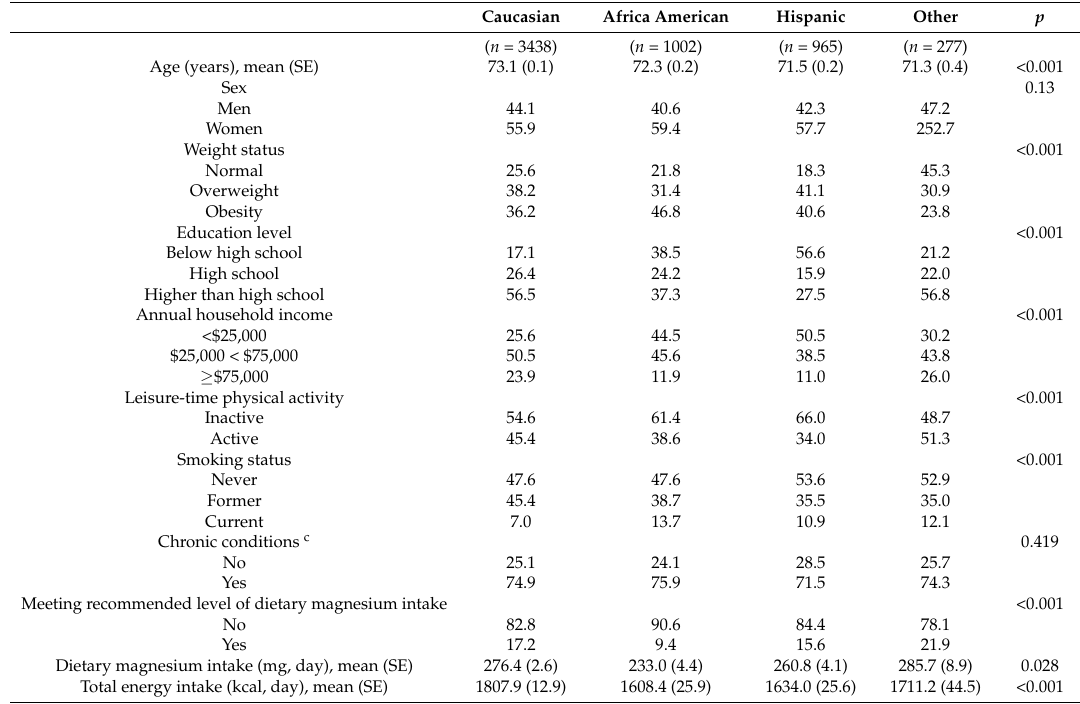
Figure 1. Participants flow chart for U.S. older adults ( ≥ 65 years) from the National Health and Nutrition Examination Survey (2005–2016). Table 1. Sample characteristics in relation to ethnicity a,b . Caucasian Africa